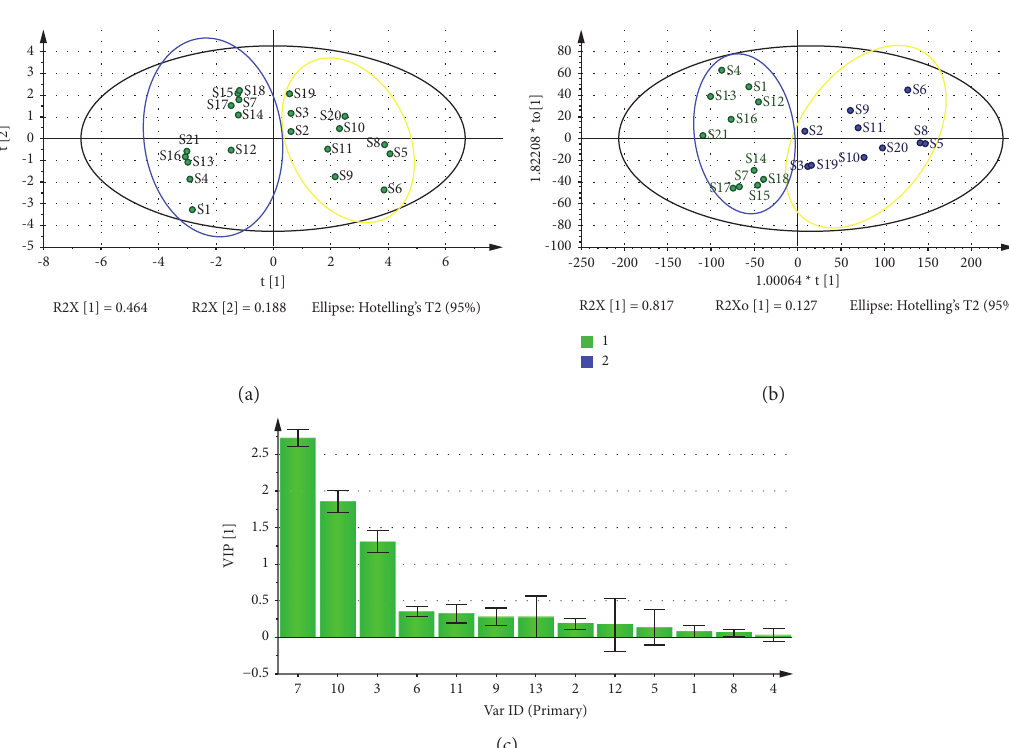
Figure 4: PCA scores plot of 21 batches of saffron (a), OPLS-DA diagram of 21 batches of saffron (b), and VIP plot of OPLS-DA of 13 characteristic peaks (c).